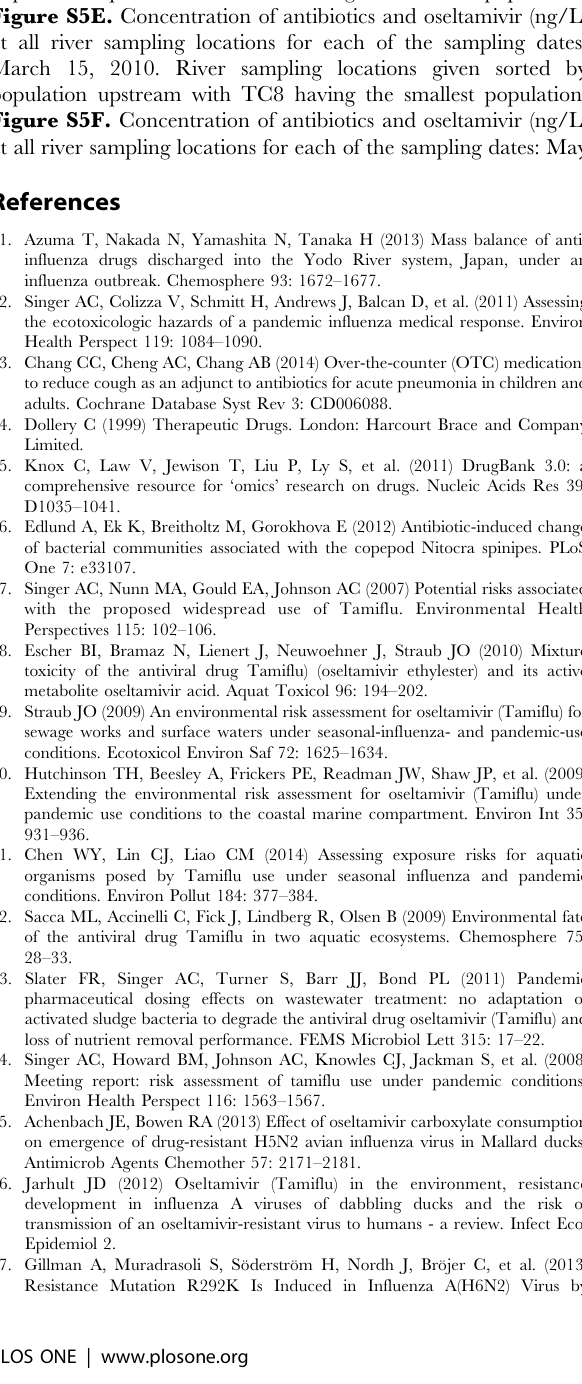
and rivers. Table S3. Liquid chromatography-tandem